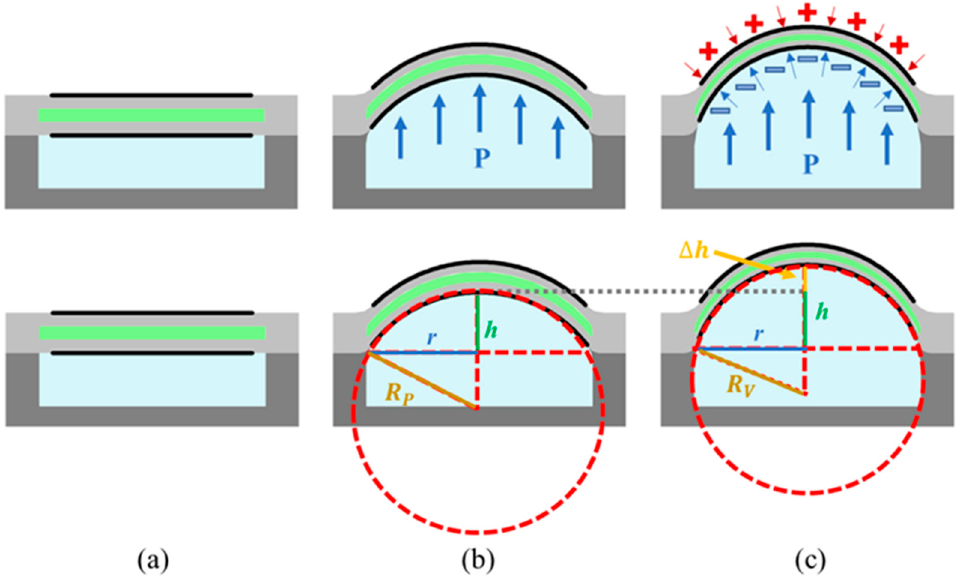
Figure 2. Schematic diagram of the SEHPA. ( a ) The initial state of the SEHPA. ( b ) Deformation driven by pressure. ( c ) Deformation driven by voltage.